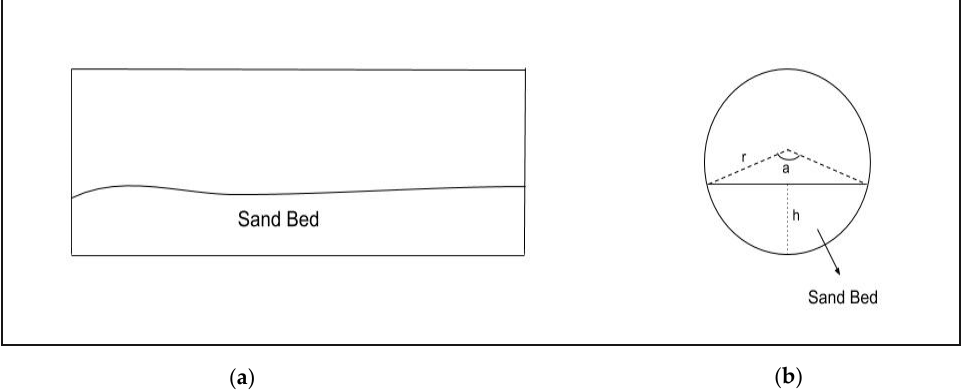
Figure A1. ( a ) Sand bed profile along the horizontal pipe and ( b ) the cross-sectional view of the pipe with the sand bed [31].